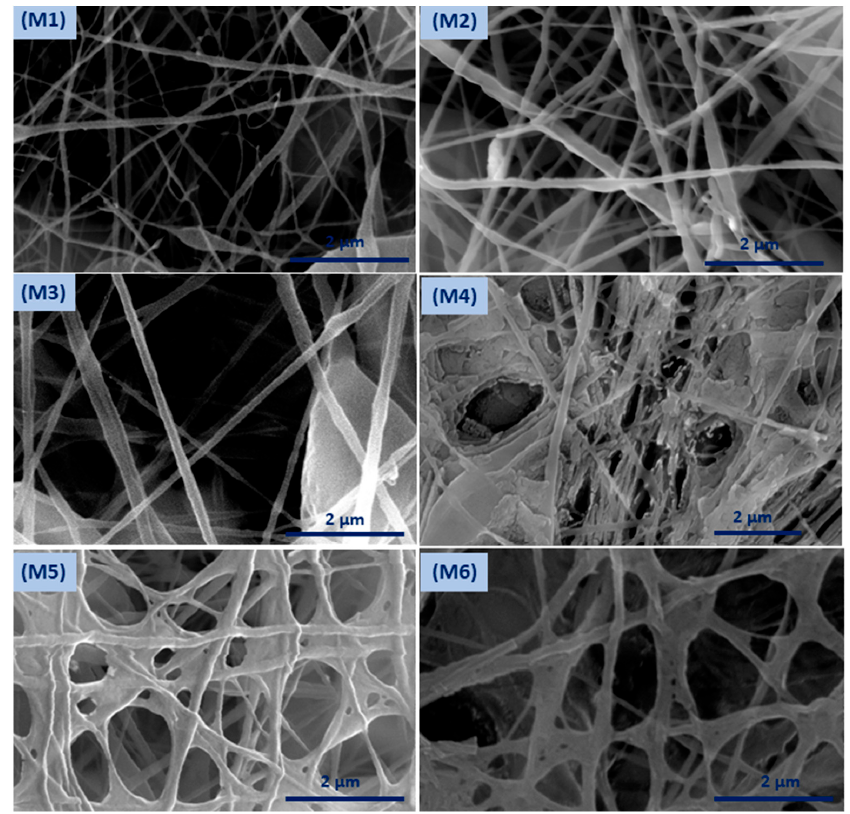
Figure 2. Field emission scanning electron microscopy (FESEM) surface morphology of the developed membranes.